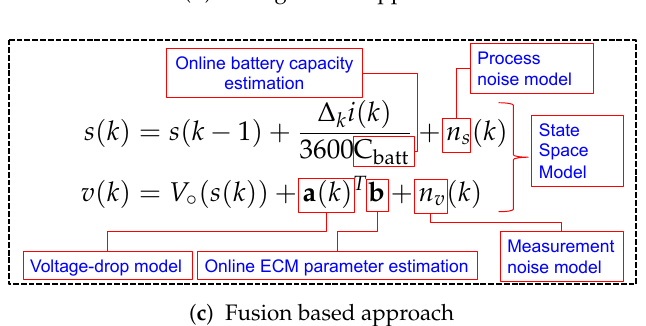
Figure 1. State of charge estimation. The fusion based approach is one of the most robust approaches to accurate battery SOC